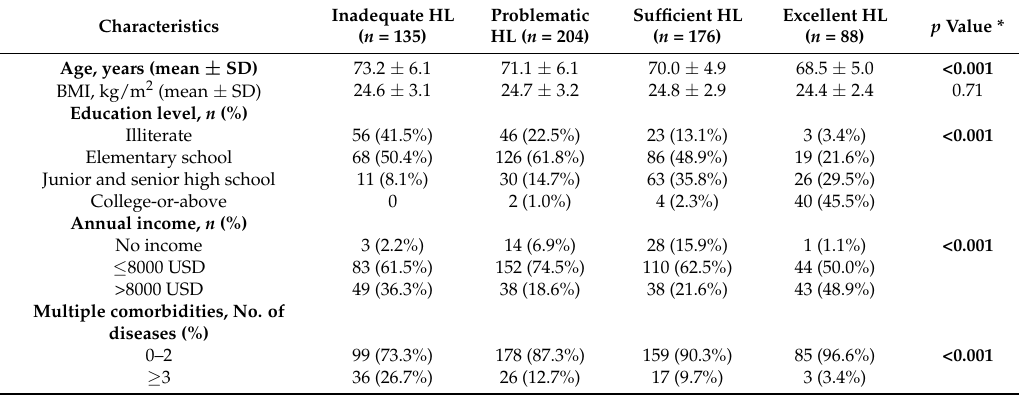
Table 2. Characteristics of the participants by health literacy